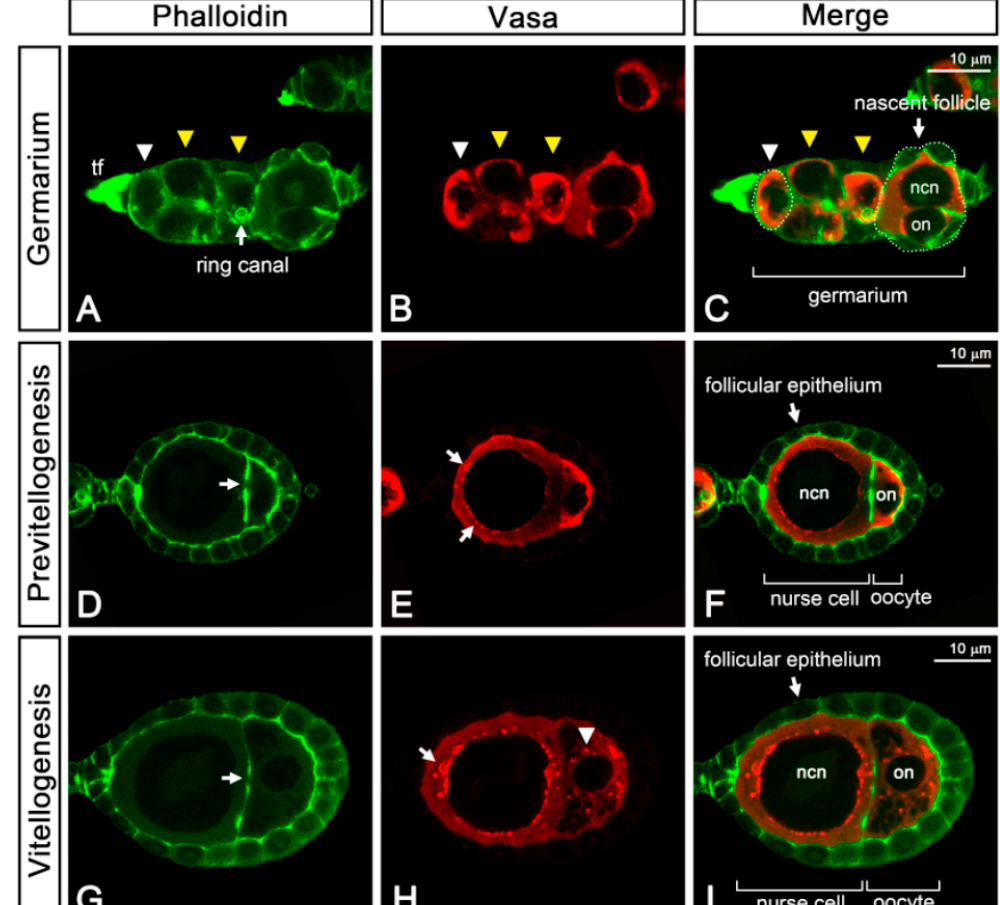
Figure 5. Ovariole structure and Vasa distribution during oogenesis. ( A – I ) Confocal micrographs showing the result of whole-mount immunostaining on ovarioles. The Phalloidin-conjugated FITC (green) and the anti-Vasa antibody (red) were used to visualize the cortical F-actin and germ line cells, respectively. Vasa specifically expressed in germline cells and enriched in the perinuclear regions of the nurse cells during vitellogenesis. ( A – C ) The germarium region. White arrowhead: germline stem cell, yellow arrowhead: cystocyte. The ring canal interconnecting cystocytes is indicated in ( A ). ( D – F ) The follicle at the previtellogenic phase from unfed females. Arrow in ( D ): ring canal; arrow in ( E ): perinuclear Vasa. ( G – I ) The follicle at the vitellogenic phase from females at six hours PBM. Arrow in ( G ): ring canal; arrow in ( H ): perinuclear Vasa; arrowhead in ( H ): Vasa aggregates in the ooplasm. ncn: nurse cell nucleus; on: oocyte nucleus; tf: terminal filament. For all the panels, anterior is to the left.